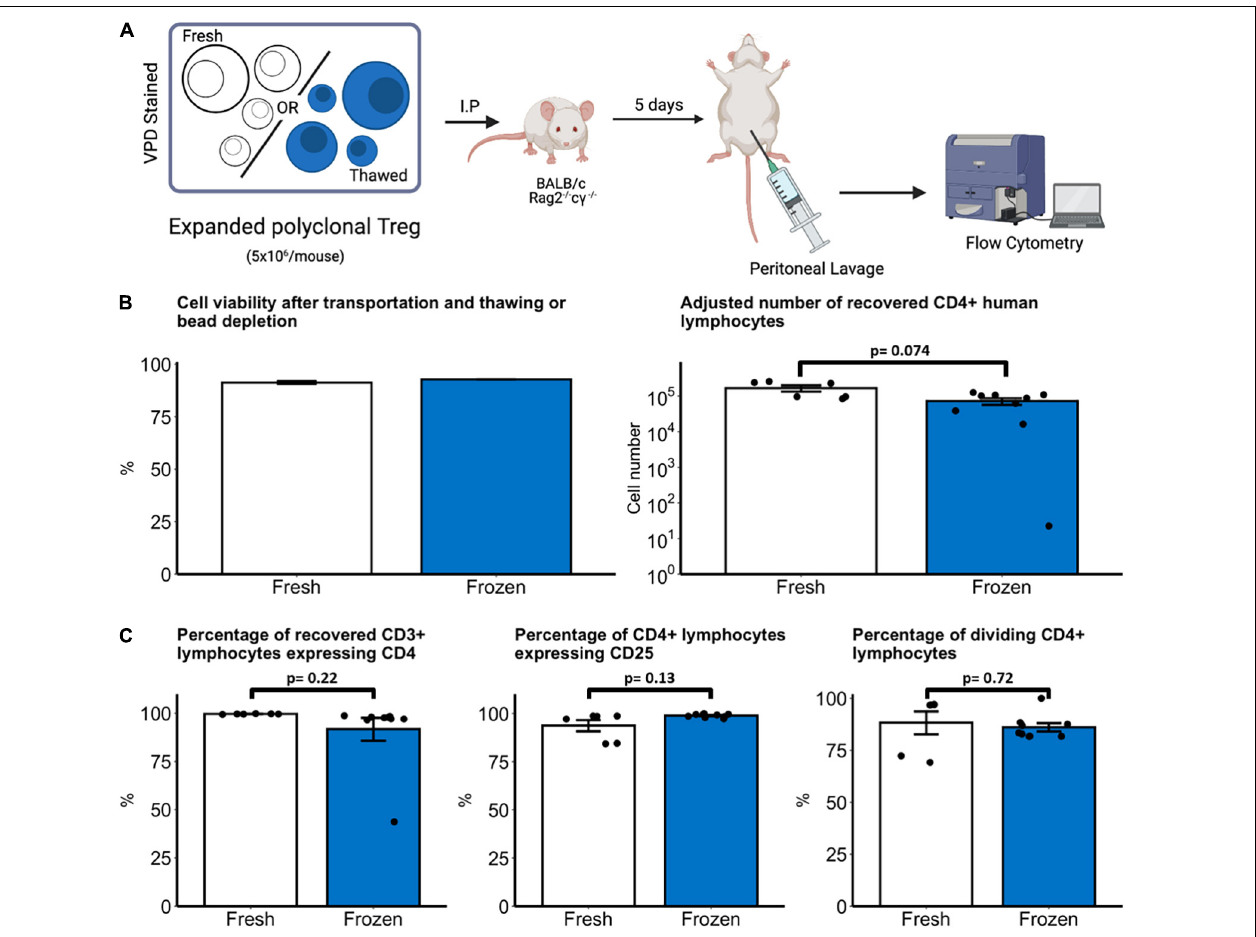
FIGURE 4 | In vivo survival of fresh and thawed nTreg. (A) Experimental schematic, created with biorender.com. Freshly expanded or cryopreserved nTreg were recovered and stained with violet proliferation dye (VPD). Before injection into mice cells were characterized for Treg markers. VPD staining ensured the traceability to Treg-positive cells for later investigations. Immunodeficient BALB/c Rag2 - / - c γ - / - mice received 5 × 10 6 VPD-labeled nTreg from one of two donors which were recovered after 5 days by peritoneal lavage (B) . Cell viability was quantified by light microscopy with 0.05% Trypan Blue dead-cell exclusion after transport and bead depletion (fresh nTreg) or transport and thawing (frozen nTreg). The number of nTreg recovered from lavage after 5 day incubation was quantified by flow cytometry. (C) Phenotype and proliferation of recovered human (mCD45 - CD3 + ) lymphocytes were quantified by expression of CD4 and CD25. Division was defined as lymphocytes with VPD staining intensity less than the maximally stained (undivided) peak. Each point represents a separate mouse with n = 2 Treg donors. Data are represented as mean ± SEM and statistical significance determined using unpaired t